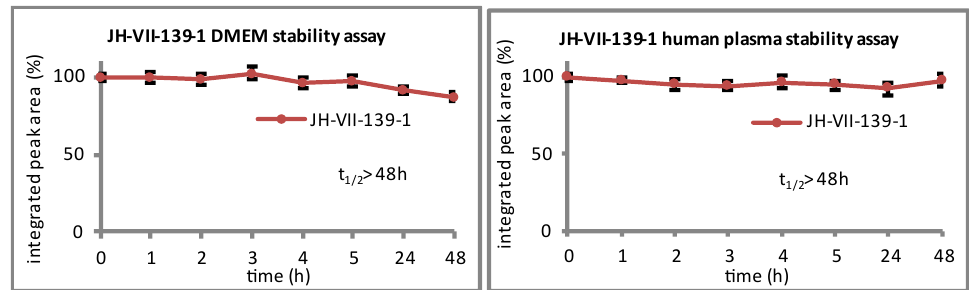
Figure 2. Chemostability of